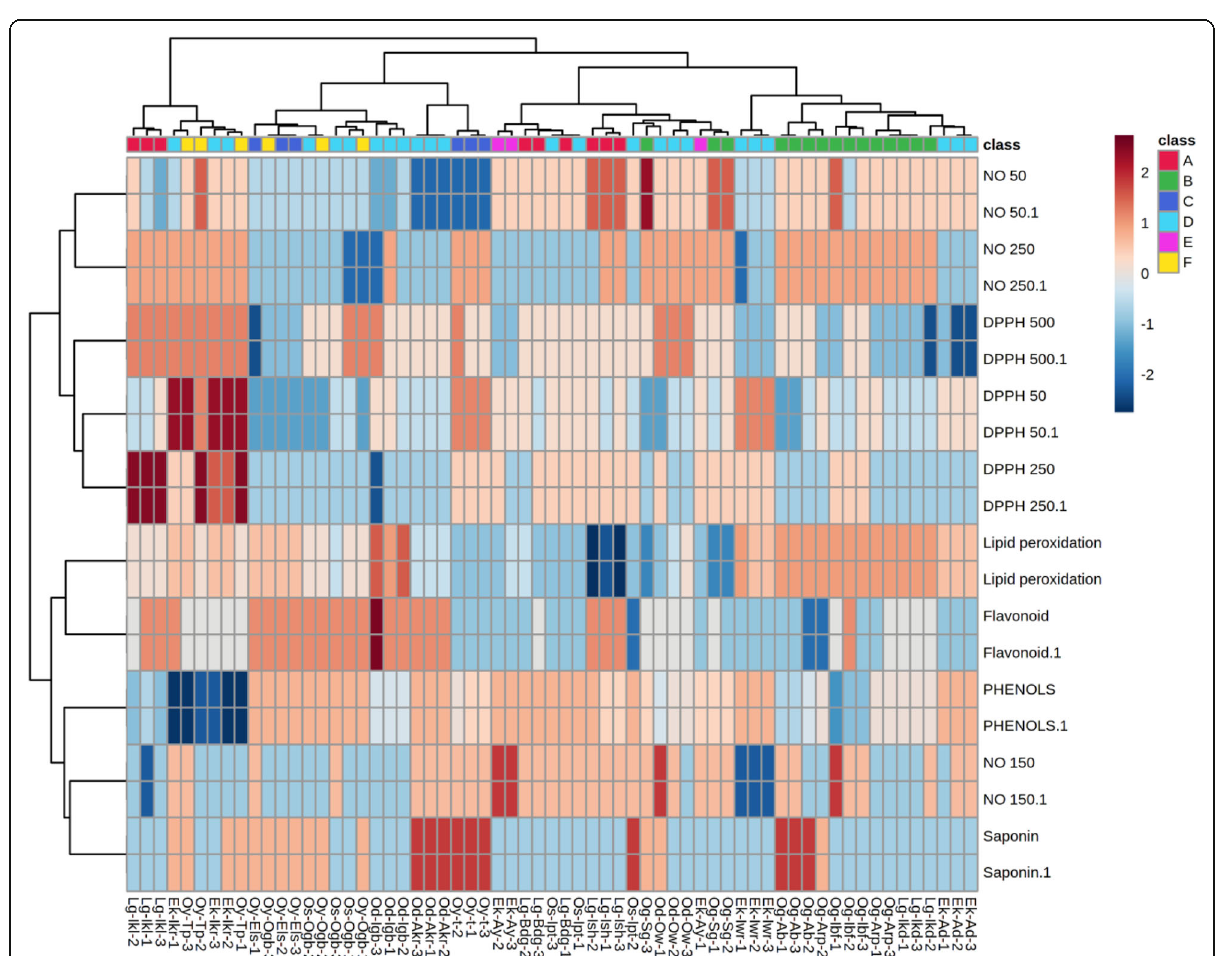
Fig. 15 Heat map of the parameters with significance. The heat map revealed at a glance the pattern of differences of the parameters checked when the different samples were grouped according to soil type using Global Mapping Unit